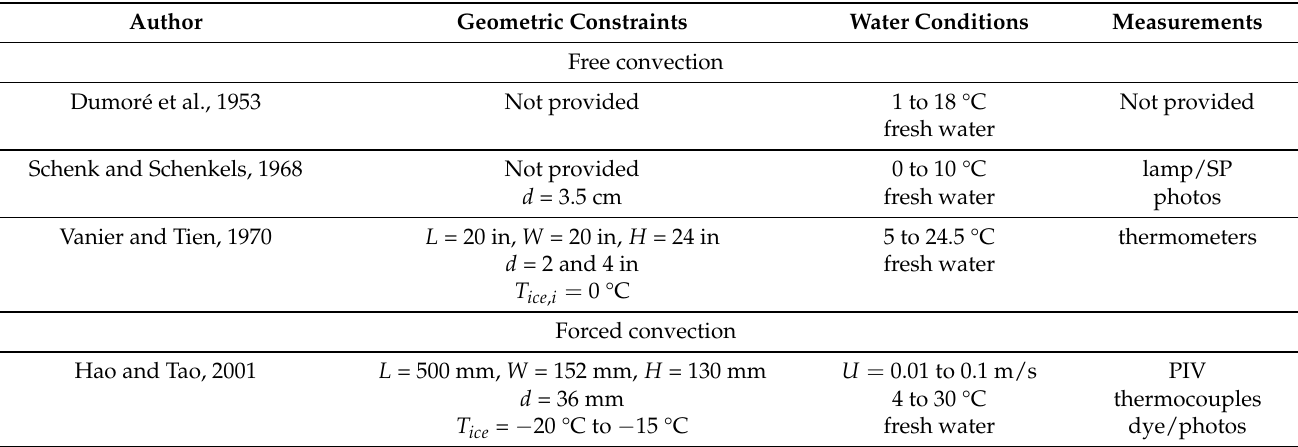
Table A7. Experiments focused on flow patterns and melting around an ice sphere in flow conditions of both free and forced